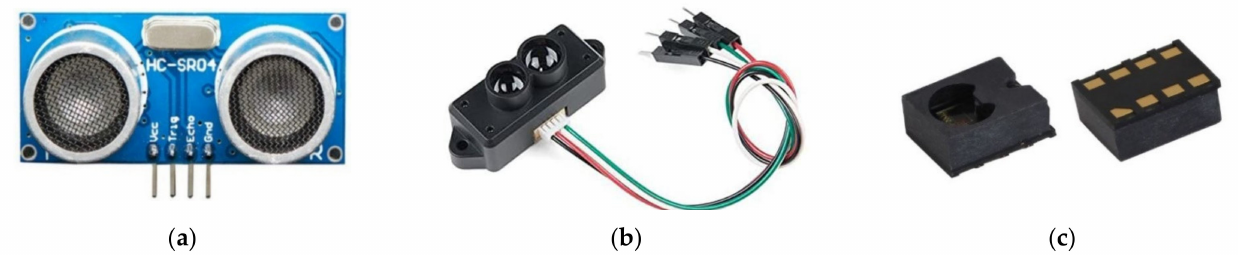
Figure 7. ( a – c ) typical models of an Ultrasonic sensor (e.g., HC-SR04), TF-mini-LIDAR (e.g., SJ-GU- TFmini-01), and Vertical-Cavity Surface-Emitting Laser (e.g., VCNL36826S), [86]; Courtesy of the Holykell Technology Company Limited, China; Shenzhen FEETECH RC Model Co., Ltd., China;